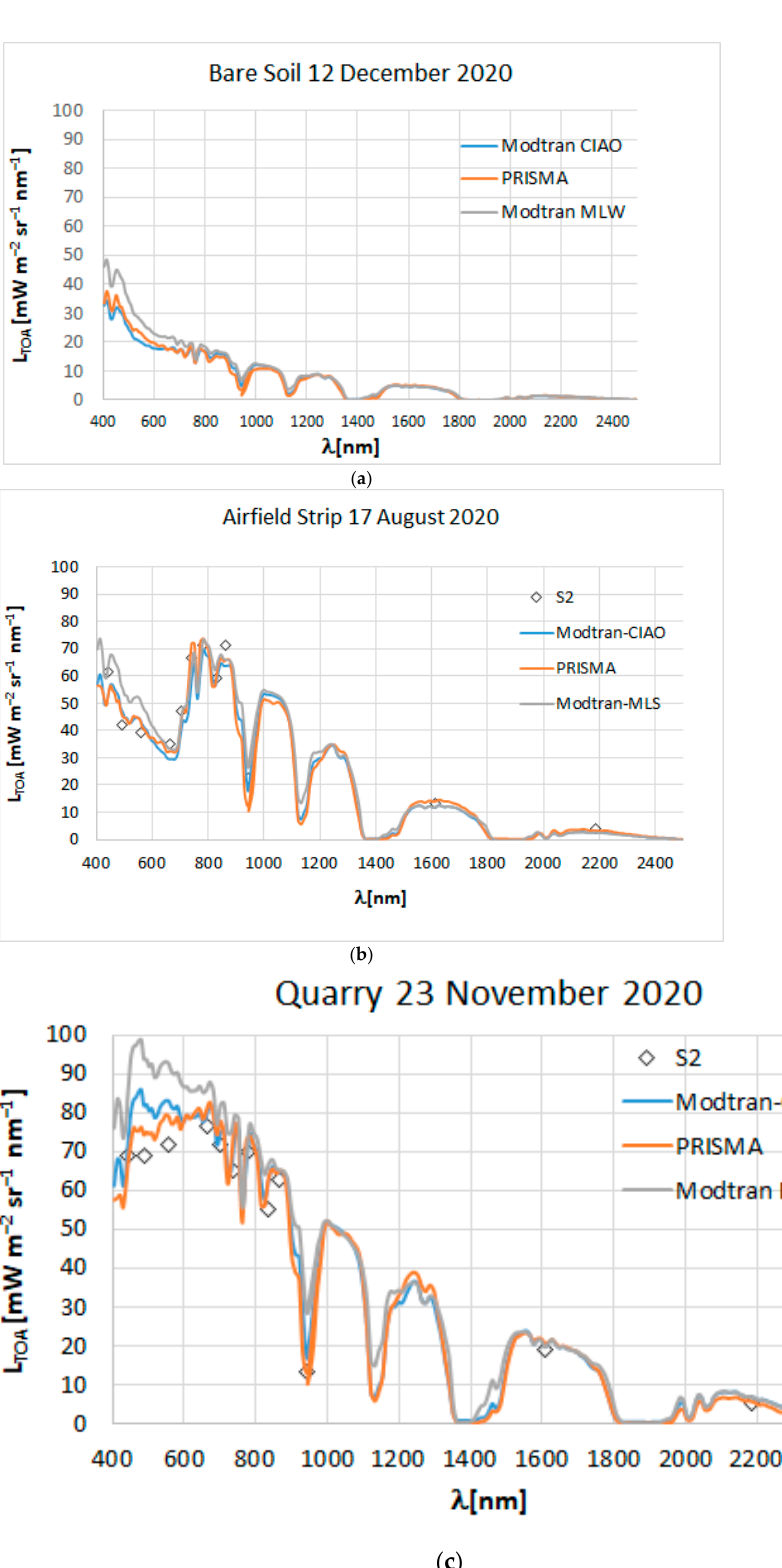
Figure 5. Examples of the comparison between L TOA (red line) and the L TOA simulated with PRISMA ASD MODTRAN and configured with the CIAO atmospheric T and RH profiles and the extinction @ 550 profiles (light blue line) and using the standard atmospheric profiles (MLW, MLS) selected according to the date (gray line): ( a ) bare soil, ( b ) meadow airfield strip, ( c ) limestone quarry. Circles depict the L TOA contemporary S 2